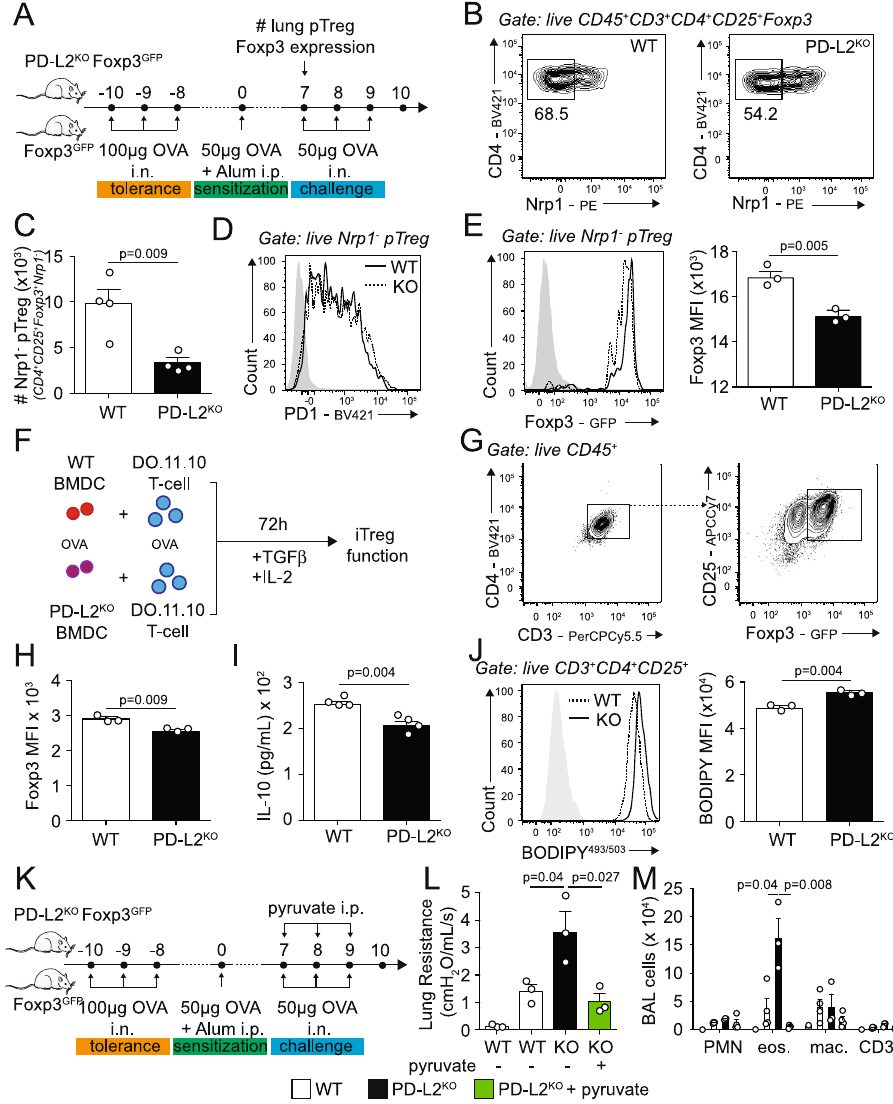
Fig. 6 | PD-L2 controls pTreg numbers and function to induce respiratory tol- erance.A Foxp3 GFP and PD-L2 KO Foxp3 GFP mice werei.n. challengedon days − 10, − 9 and − 8 with 100 µ g ovalbumin (OVA). On day 0, mice were intraperitoneally sen- sitized with 50 µ g OVA emulsi fi ed in alum (1:1) and CD3 + CD4 + CD25 + Foxp3 GFP+ Nrp1 − pTreg numbers were analyzed by fl ow cytometry on day 7. B Representative plots ofpTregsinthelungsofFoxp3 GFP andPD-L2 KO Foxp3 GFP mice. C NumbersofpTregs in the lungs of Foxp3 GFP and PD-L2 KO Foxp3 GFP micepresented as mean±SEM. n =4 biologically independent mice. D Representative plots of PD-1 expression in lung pTregs from Foxp3 GFP and PD-L2 KO Foxp3 GFP . E Representative plots of Foxp3 expression in lung pTregs from Foxp3 GFP and PD-L2 KO Foxp3 GFP mice and corre- sponding quantitation presented as mean±SEM. n =3 biologically independent mice. F BALB/c (WT) and PD-L2 KO BMDC were differentiated in vitro for 7 – 10 days and cultured with FACS-sorted CD4 + CD44 − CD62L + KJ1-26 + naive T cells in the pre- sence of IL-2, TGF- β , 100ng/mL OVA peptide and CD3/CD28 stimulation to induce Treg differentiation for 72h at 1:20 ratio. G Representative plot of Foxp3 expres- sion. H Foxp3 expression in T cells incubated with either WT or PD-L2 KO BMDC,